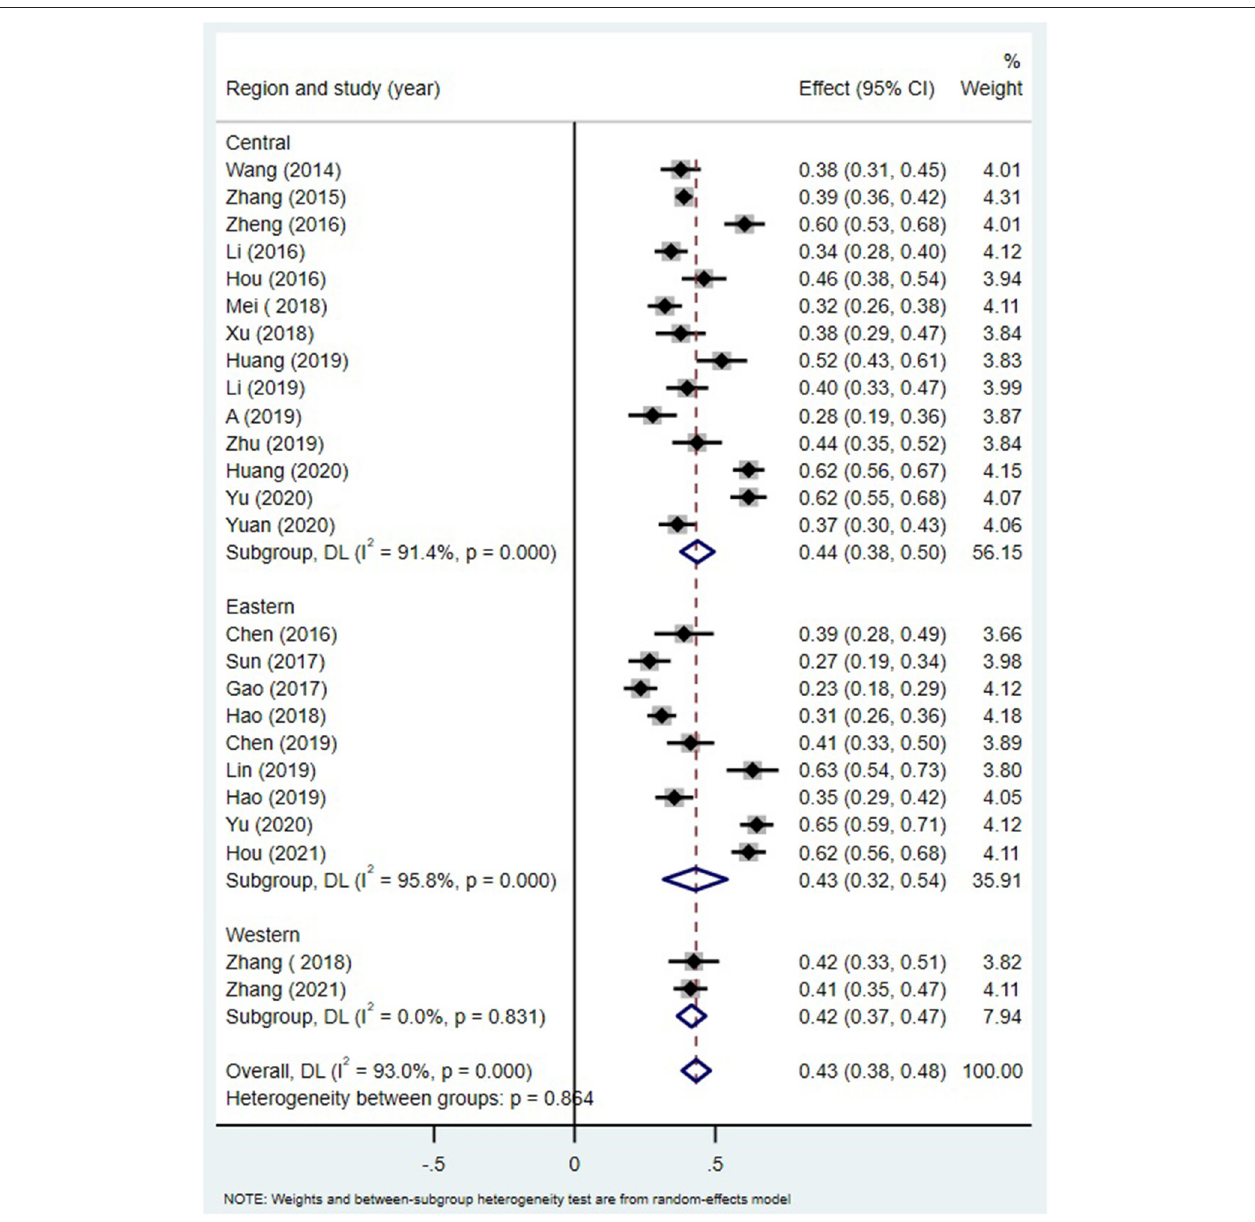
FIGURE 7 | MPA and alexithymia: an analysis of the moderating effects ofregion.